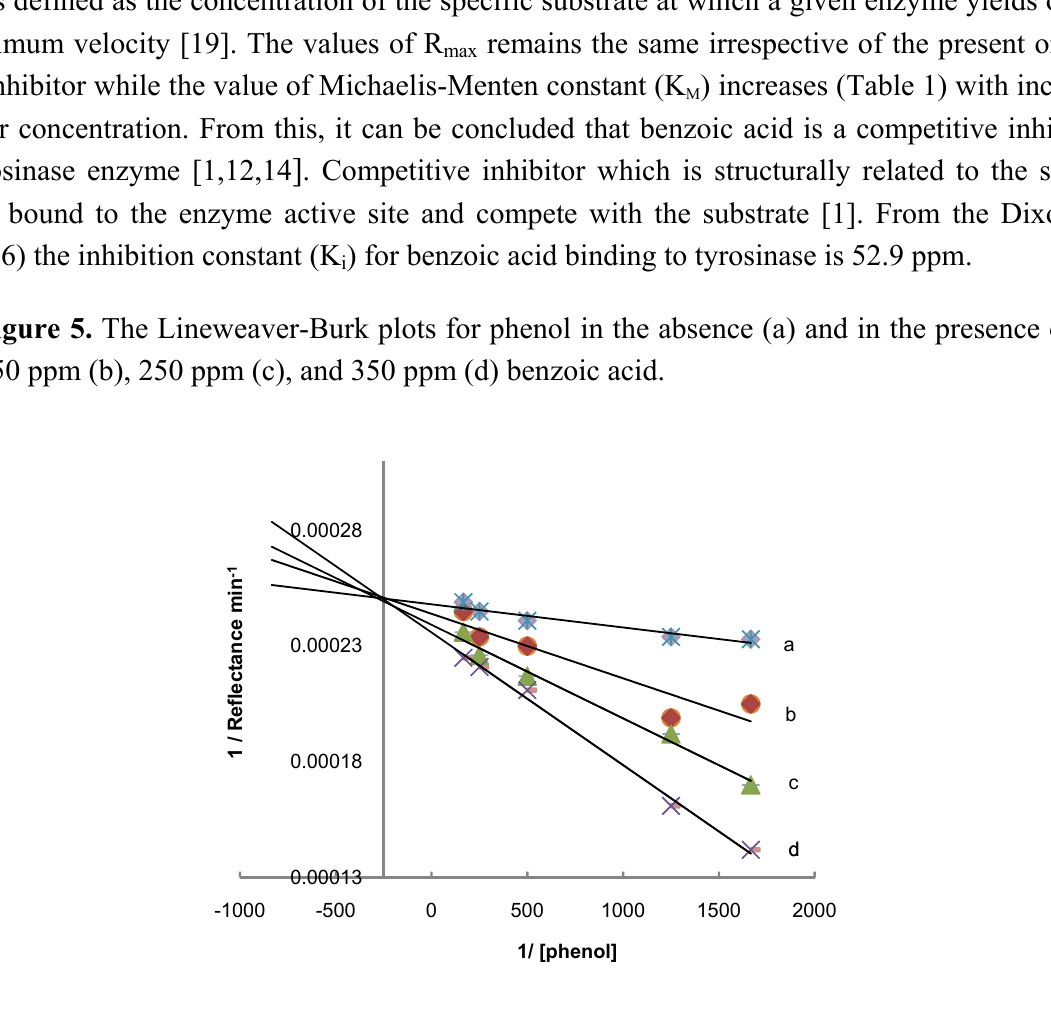
Figure 6. The Dixon plots of benzoic acid inhibition in the presence of 0.002 M (a), 0.004 M (b), 0.006 M (c), 0.008 M (d), and 0.01 M (e)